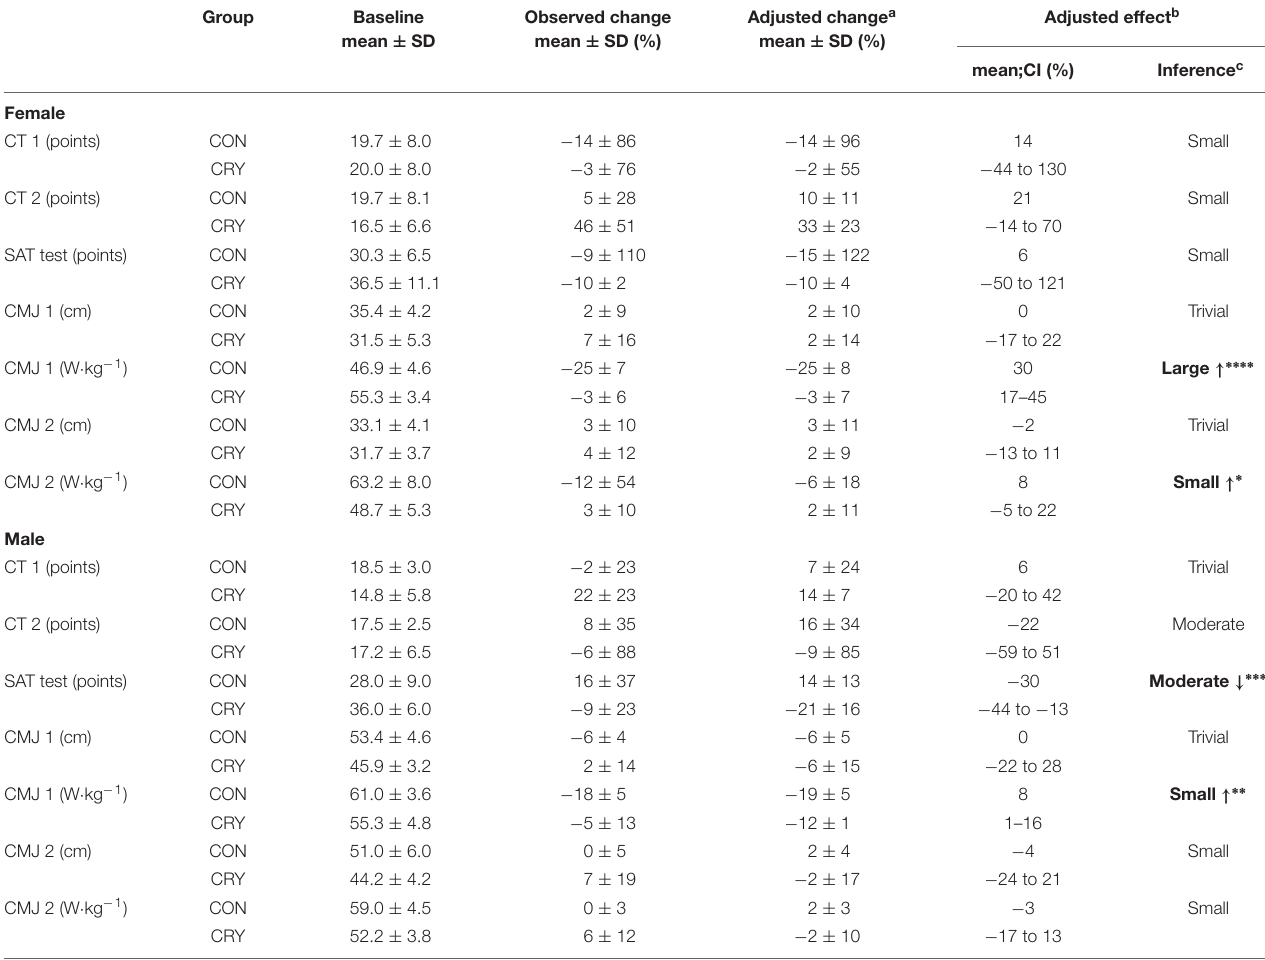
TABLE 3 | Changes in motor abilities and concentration test after the 2 week training program combined with two different recovery methods (cryostimulation or passive rest). Adjusted effect b Group Baseline Observed change Adjusted change a mean ± SD (%) mean ± SD mean ± SD (%) mean;CI (%) Inference